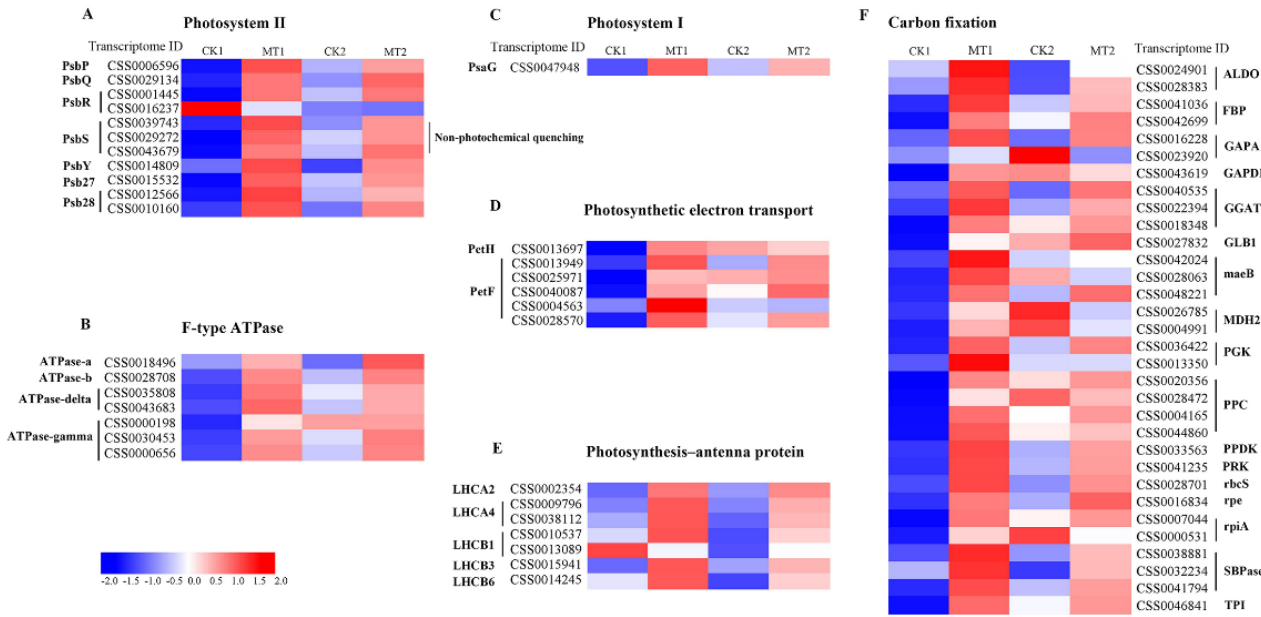
Figure 6. Heatmap of expression levels of photosynthesis related genes identified in DEGs. Blue and red represent low and high expression, respectively. ( A ) Photosystem II; ( B ) F-type ATPase; ( C ) Photosystem I; ( D ) Photosynthetic electron transport; ( E ) Photosynthesis-antenna protein; ( F ) Carbon fixation.